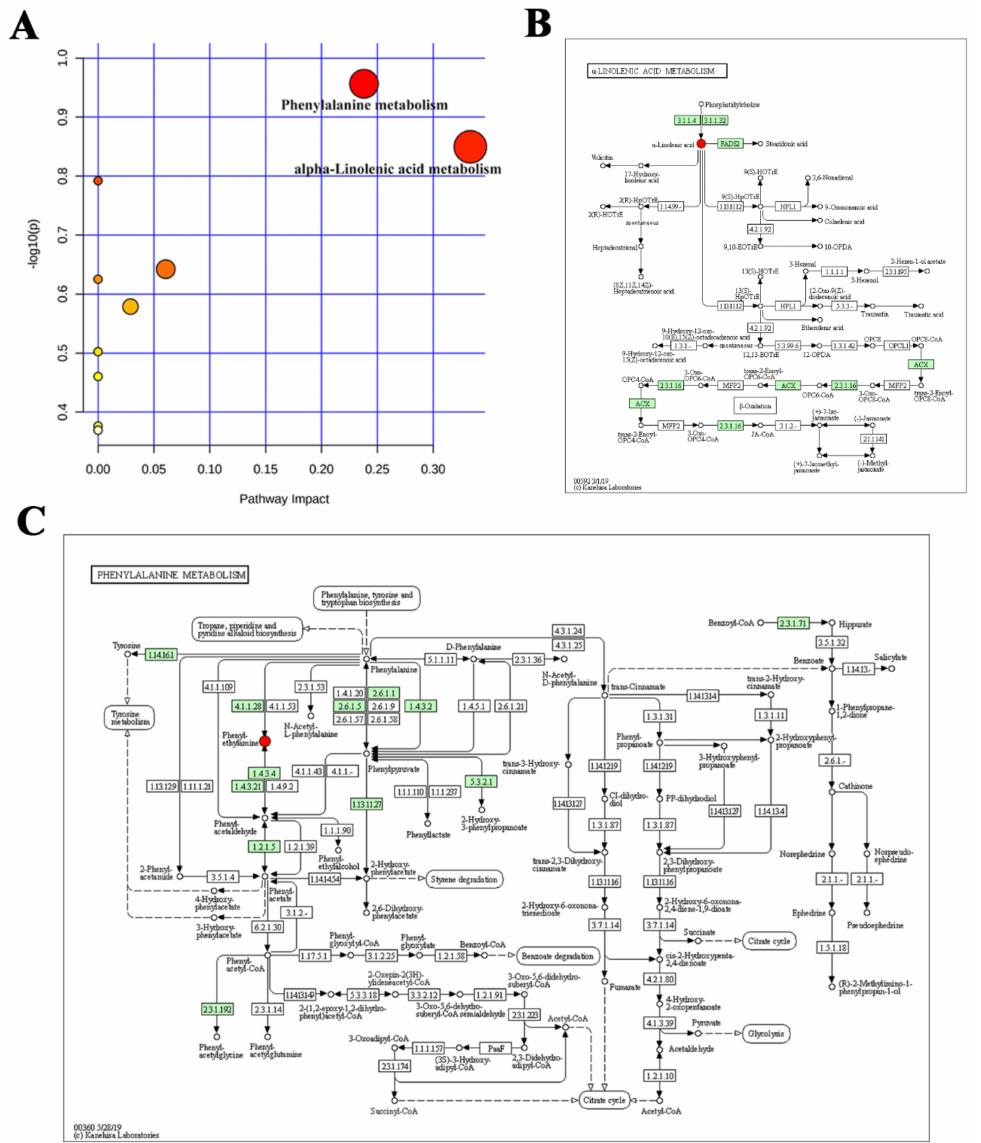
Figure 10. ( A ) Metabolic pathway of differential metabolites between NS and Mix group enriched by MetaboAnalyst 5.0. ( B , C ) KEGG enrichment pathway of α -linolenic acid metabolism and phenylala- nine metabolism,